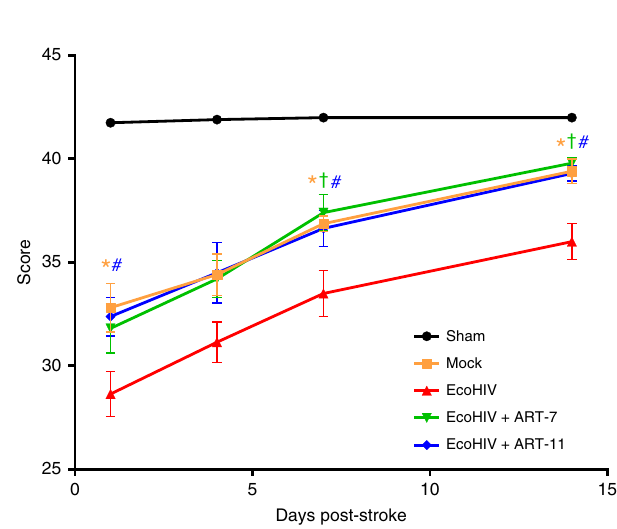
Fig. 8 ART accelerates post-ischemic stroke functional recovery. Mice were infected, treated with ART-7 and ART-11, and subjected to stroke as in Figs. 6 and 7, followed by evaluation for neurode fi cit score at days 1, 4, 7, and 14 post-stroke; n = 9 – 20 mice per group, 2 independent experiments. Data presented as mean and SEM. Source data are provided as a